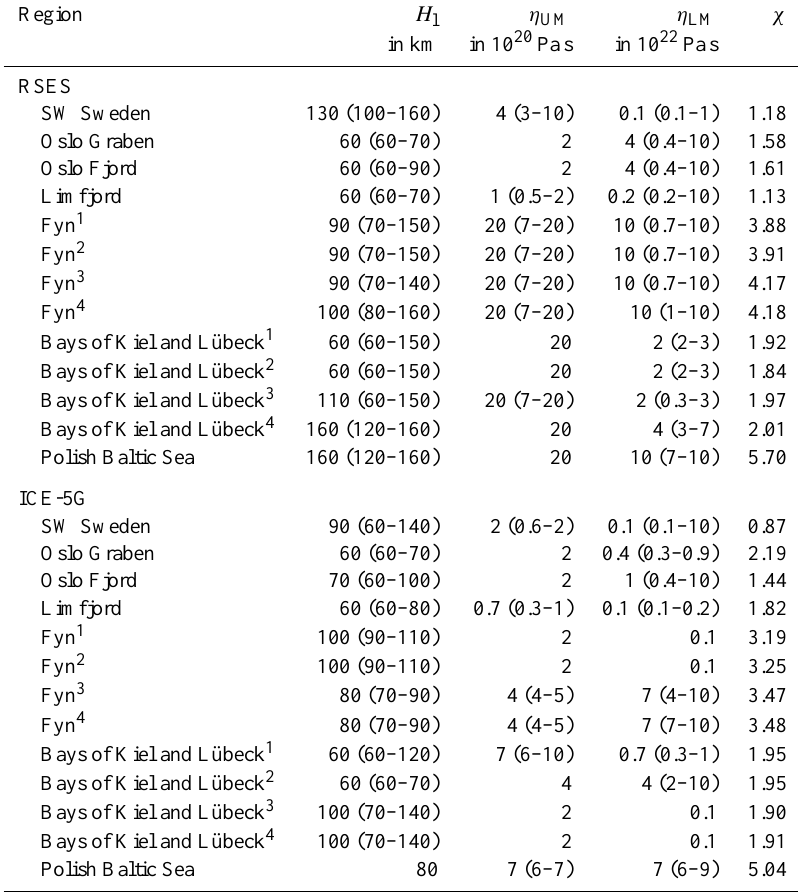
Table 1. Best-fitting three-layer 1-D earth models with RSES and ICE-5G ice-load history, respectively, as derived for each regional RSL data subset. Values in parentheses show the σ 1 range for each model parameter. If no parentheses appear, the σ 1 range encompasses the best-fitting model only. H l lithospheric thickness, η UM upper-mantle viscosity, η LM lower-mantle viscosity, χ